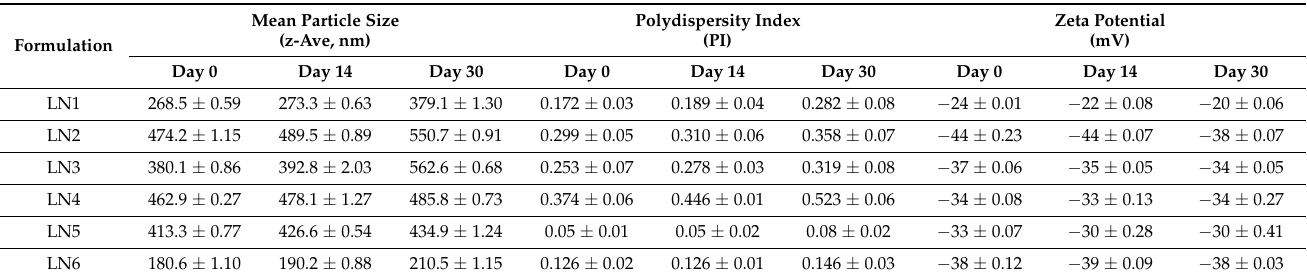
Polydispersity Index